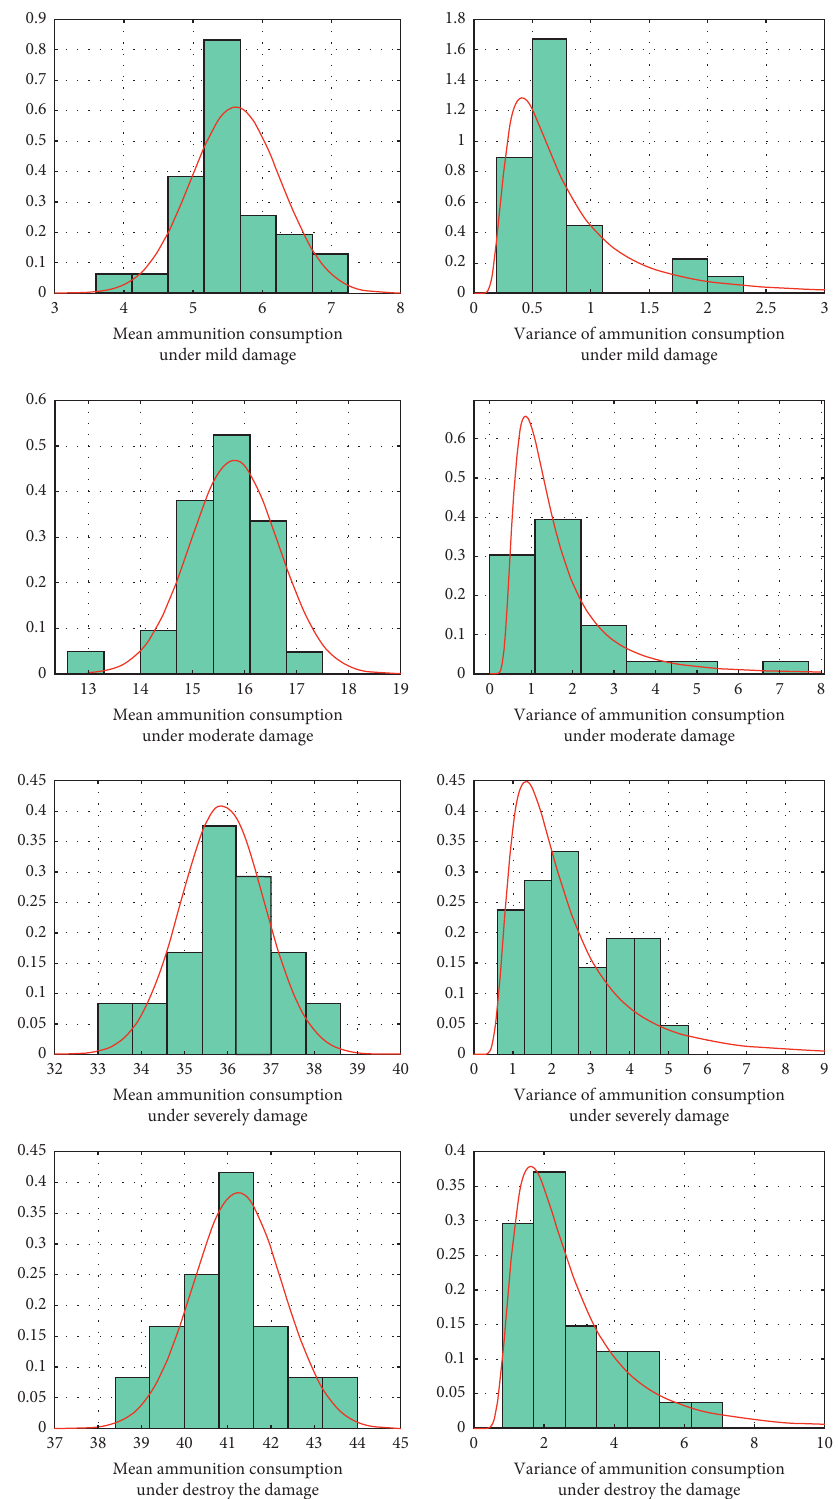
Figure 1: Frequency histogram of prior sample